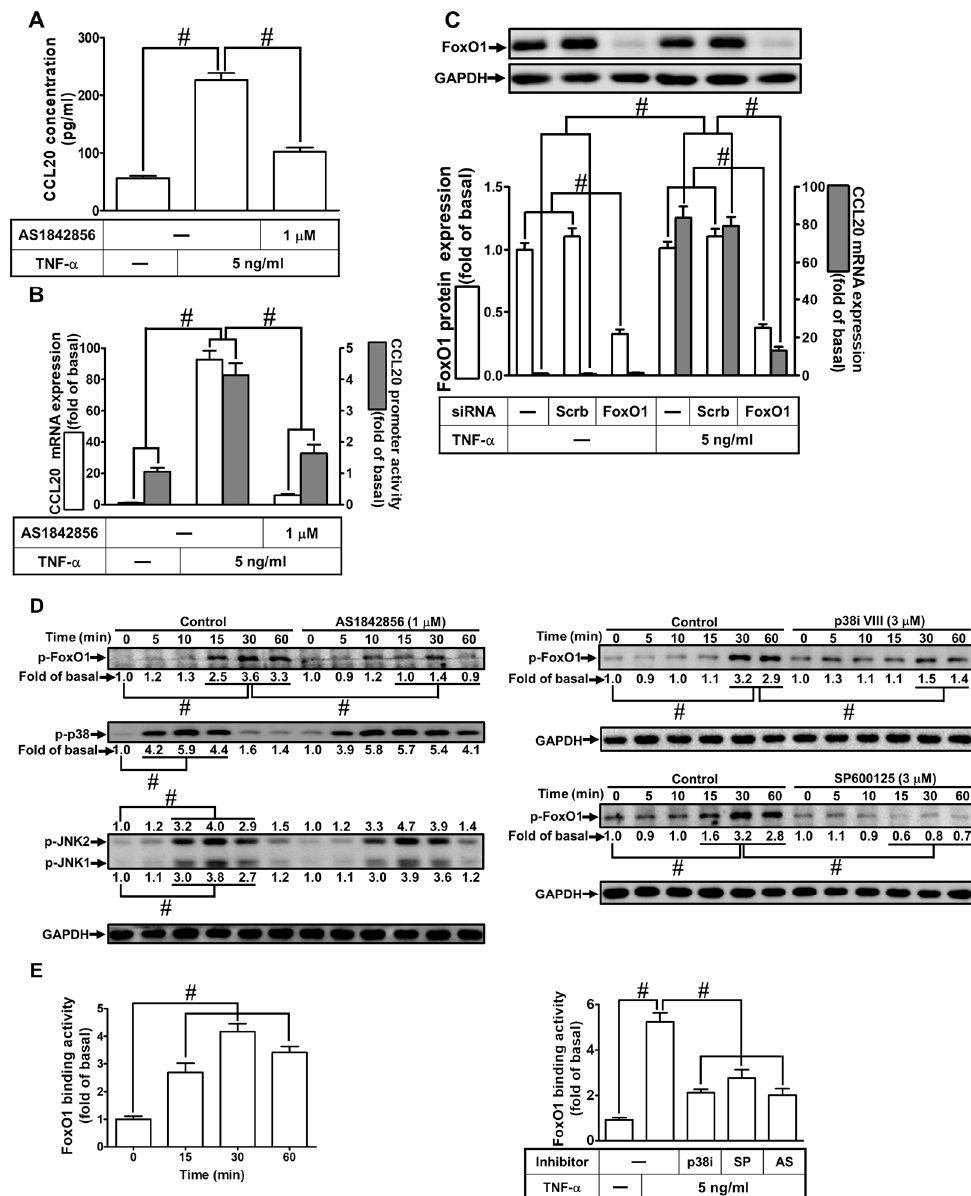
Figure 6. Involvement of FoxO1 in TNF- α -induced CCL20 expression. ( A ) Cells were pretreated with 1 µ M AS1842856 for 1 h and then incubated with 5 ng/mL TNF- α for 12 h. The conditioned media were utilized to determine the CCL20 level via an ELISA kit. ( B ) Cells were pretreated with 1 µ M AS1842856 for 1 h and then incubated with 5 ng/mL TNF- α for the indicated time. The mRNA levels and promoter activity of CCL20 were determined by real-time PCR (2 h) and promoter assay (4 h), respectively. ( C ) Cells were transfected with scrambled or FoxO1 siRNA and then incubated with TNF- α for 2 h. The mRNA levels of CCL20 were determined by real-time PCR. The protein levels of FoxO1 were determined by Western blot with GAPDH as a loading control. ( D ) Cells were pretreated without or with 1 μ M AS1842856, 3 μ M p38i Ⅷ , or 3 μ M SP600125 for 1 h and then treated with TNF- α for the indicated times (0, 5, 10, 15, 30, and 60 min). The phosphorylation of FoxO1, p38, or JNK1/2 was determined by Western blot with GAPDH as a loading control. ( E ) Cells were pretreated without or with 3 μ M p38i Ⅷ , 3 μ M SP600125, or 1 μ M AS1842856 for 1 h and then stimulated with TNF- α for the indicated time intervals or 30 min. The binding of FoxO1 to the promoter region of CCL20 was determined with a ChIP assay. Data are expressed as mean ± S.E.M. of three independent experiments ( n = 3). # p < 0.05, as compared with the cells exposed to vehicle alone; or significantly different as indicated.